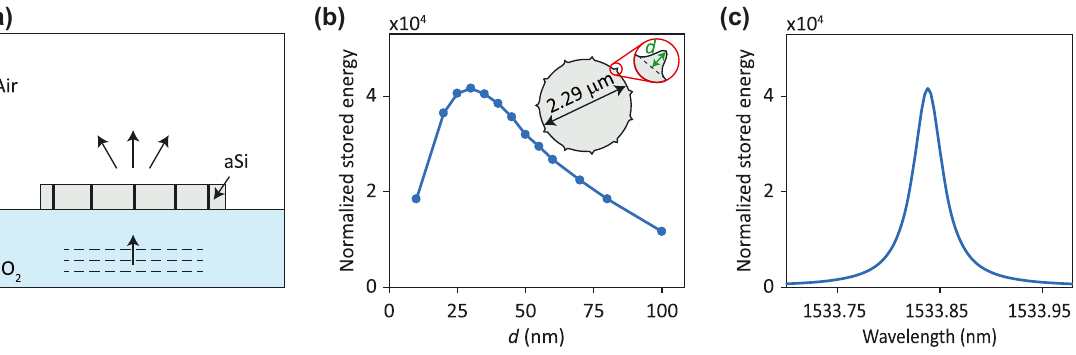
Figure 2: Excitation of an FSC microdisk resonator by a plane wave. (a)Illustrationof anFSCmicrodiskresonatorexcited byanormallyincidentplane wave.(b)Normalized storedenergy U s /( u in λ 0 3 ) as afunction ofthegratingprotrusion d atitsresonantwavelength,and(c)asafunctionwavelengthfor d =30nm.Theboundaryofthemicrodiskisde fi ned in polar coordinates according to ρ = R 0 + d (sin m ϕ ) n , where R 0 = 1.145 µm, m = 5.5, and n =